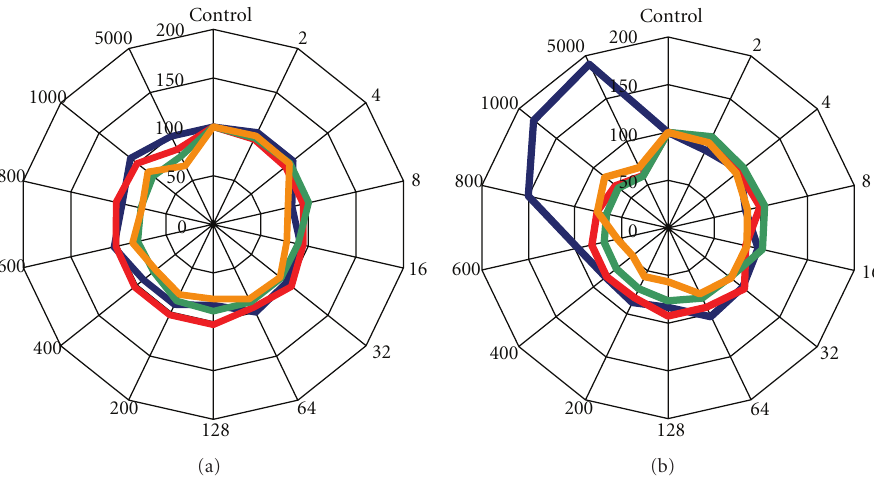
Figure 7: Complex e ff ect of glufosinate ammonium on the well-filled (a) and the low-filled spikes (b). Colour key: blue—number of spikes; red—number of grains per spikes; green—thousand kernel weight; yellow—summarized yield of spikes. Control treatment represents 100 per cent. Values are equal to the average of the eight repeat